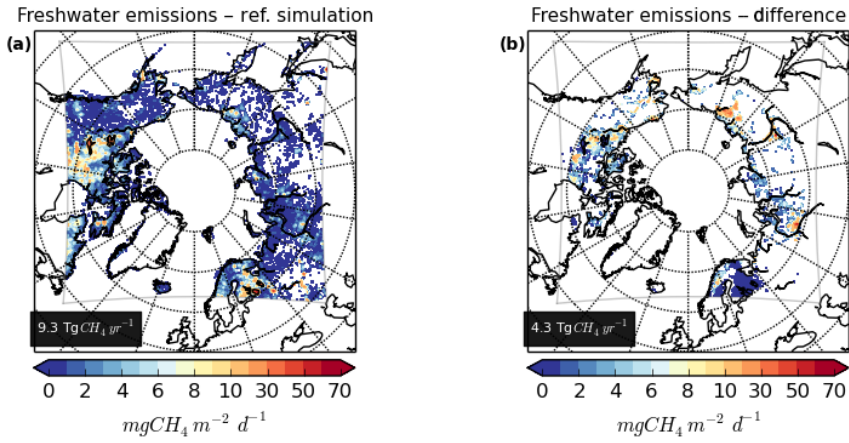
Figure 2. (a) Freshwater methane emissions used in the reference simulation. (b) Difference between the inventory based on the bLake4Me lake emission model (Tan and Zhuang, 2015a) and the one used in the reference simulation. For both maps, blank areas in the domain correspond to zero